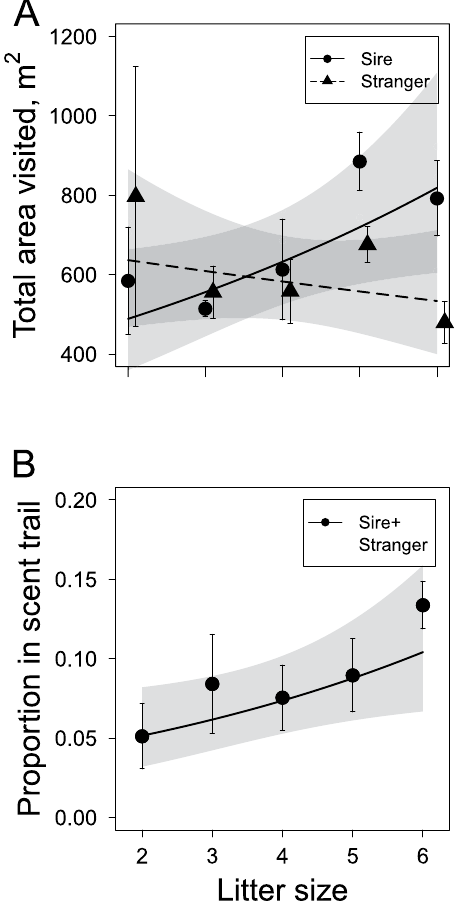
Figure 2. The total area (m 2 ) visited by female bank voles ( A ) and the proportion of locations spent in the scent trail ( B ) in relation to litter size during five hours following the spread of the male’s scent. Shown are means (symbols and error bars), model predictions (lines) and 95% confidence intervals (shaded